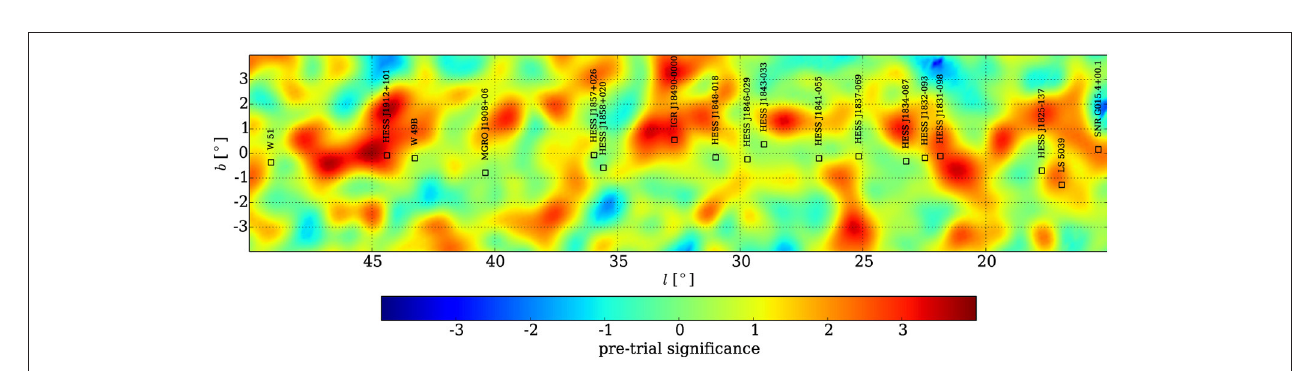
FIGURE 3 | A model with eleven sources Black circles demonstrate the five regions of interest (ROI).